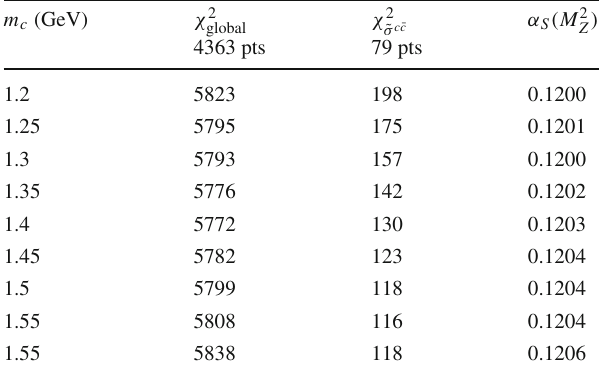
Fig. 15 The quality of the fit versus the quark mass m c at NLO with α S ( M 2 W asymmetry data Table 5 The quality of the fit versus the quark mass m c at NLO with α ( M 2 ) left as a free S Z